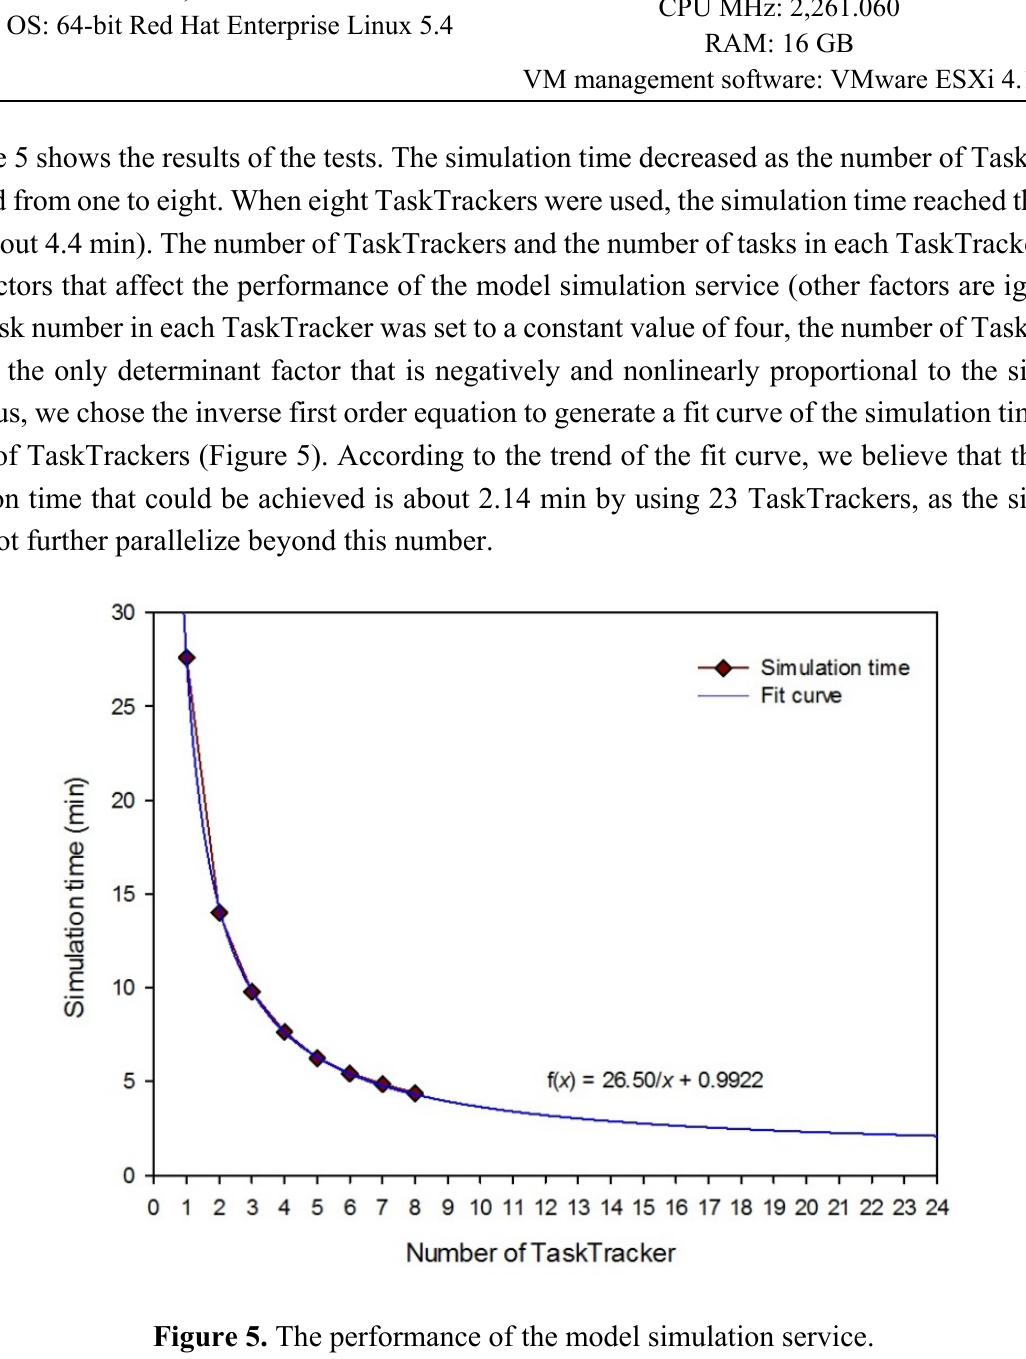
Figure 5. The performance of the model simulation